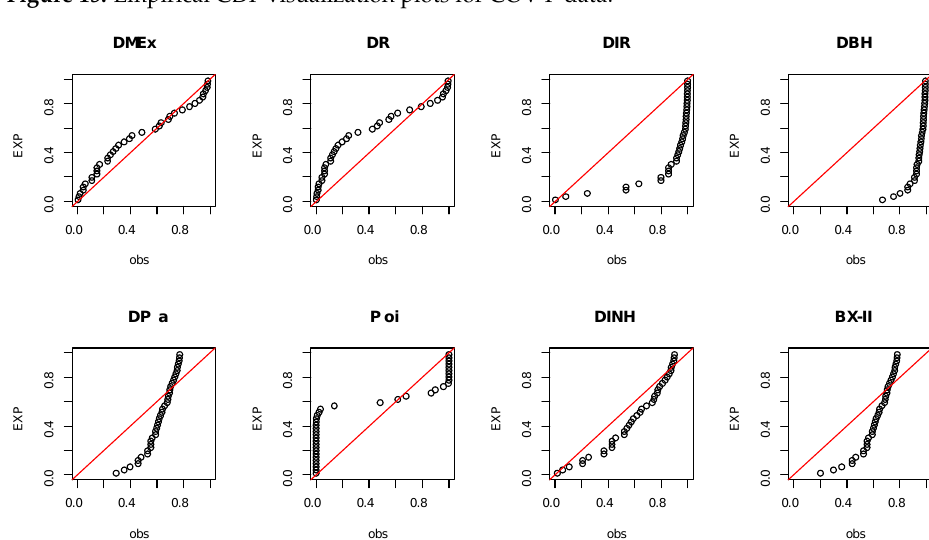
Figure 16. P-P visualization plots for COV-P data. Figure 16 . P-P visualization plots for COV-P data.